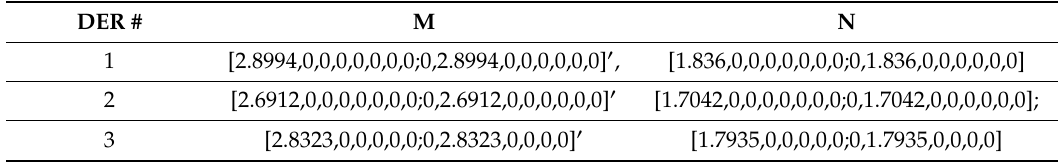
Table 2. Norm-bounded uncertainties in ∆ A i , j